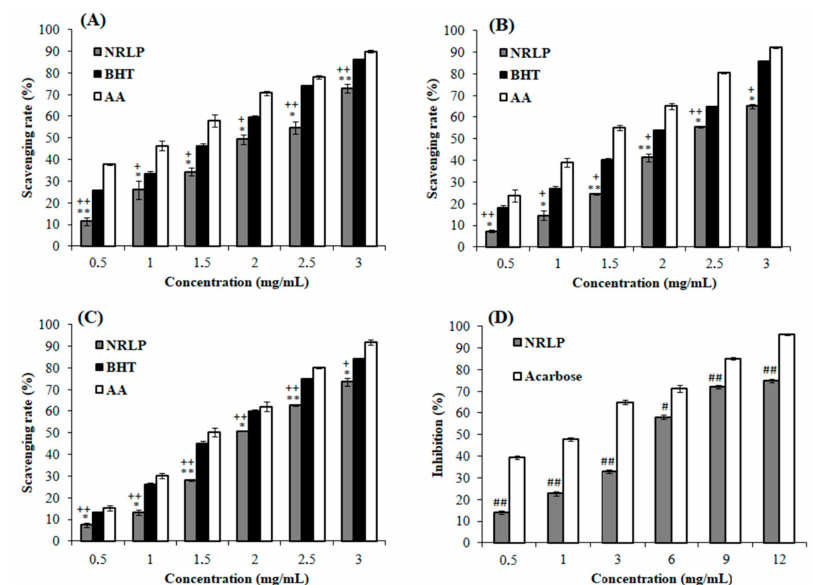
Figure 4. Antioxidant capacity of NRLP evaluated using ( A ) phospho-molybdenum, ( B ) hydroxyl and ( C ) DPPH radicals scavenging assays in di ff erent solutions and ( D ) the α -amylase inhibition e ff ect. Data are shown as means of three separate experiments. * p < 0.1 and ** p < 0.01 compared with the positive control ascorbic acid (AA). + p < 0.1 and ++ p < 0.01 compared with the positive control butylhydroxytoluene (BHT). # p < 0.05 and ## p < 0.01 compared with the positive control